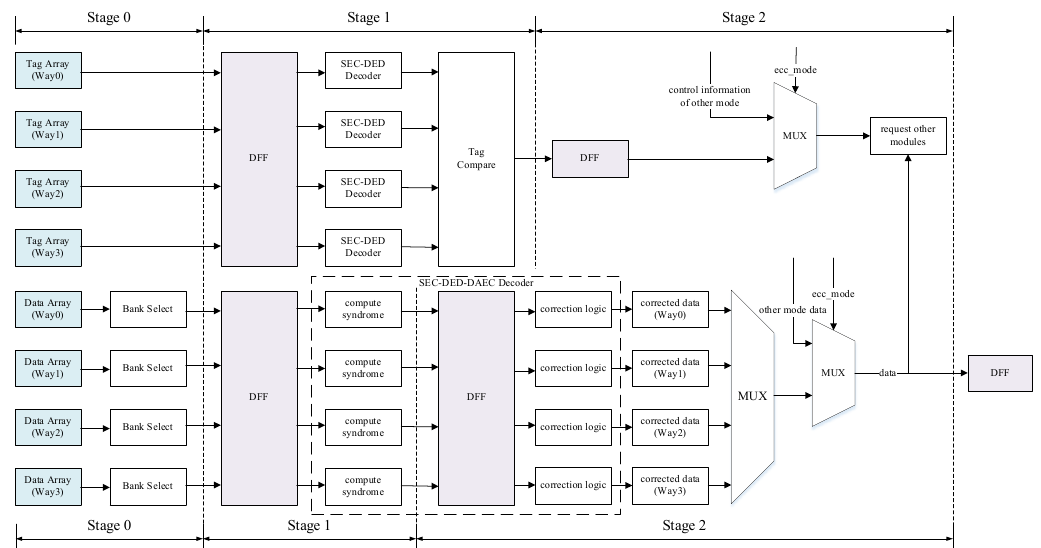
Figure 3. Proposed high-reliability design scheme with ECC protection in cache.